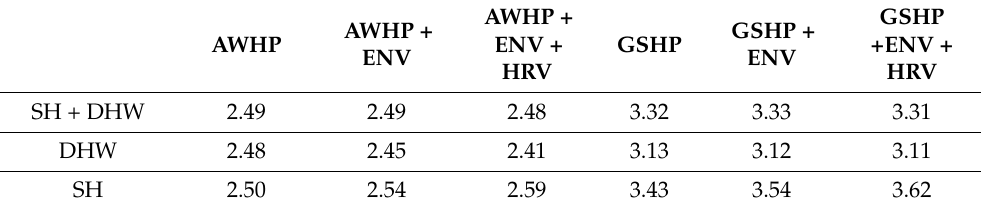
Figure 10. Coefficient of performance of DHW and space heat (SH) ( a ) AWHP + ENV case and ( b ) GSHP + ENV case. Table 5. Coefficient of performance for different cases using heat pump systems.